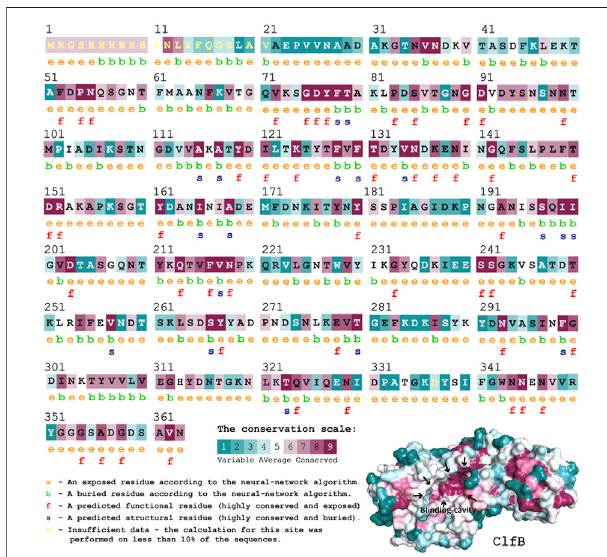
FIGURE 3 | Structural prediction of ClfB protein, which contained the most secondary structures of β -folding (45.03%), followed by irregular coiling (36.65%), β -turning (11.49%), and α -helix (5.59%), and the binding cavity of ClfB comprised 20 amino acids, like L82, D84, D91, T100, D120, and G201.